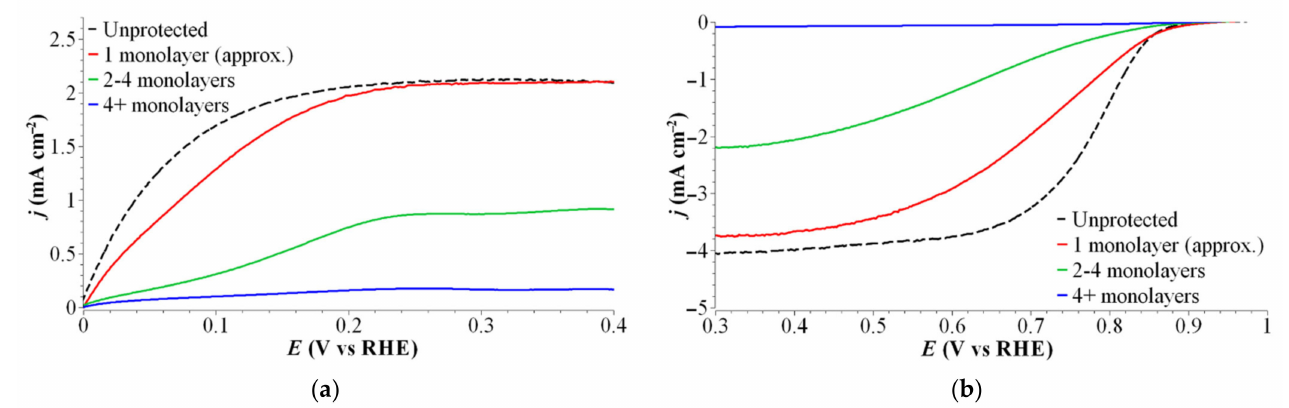
Figure 3. Linear sweep voltammograms (LSVs) of the ( a ) HOR (H 2 saturated) and ( b ) ORR (O 2 saturated) with different levels of Cr x O y H z coverage, both in 0.1 M NaOH (aq) at 50 mV s − 1 , at 900